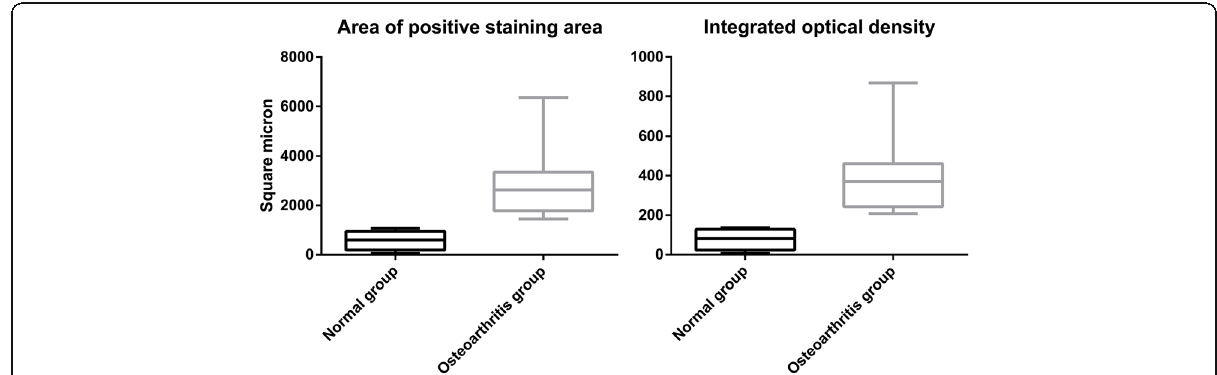
Fig. 6 Statistical results of the area of positively-stained area and the integrated optical density for NDRG3 in the normal group and osteoarthritis